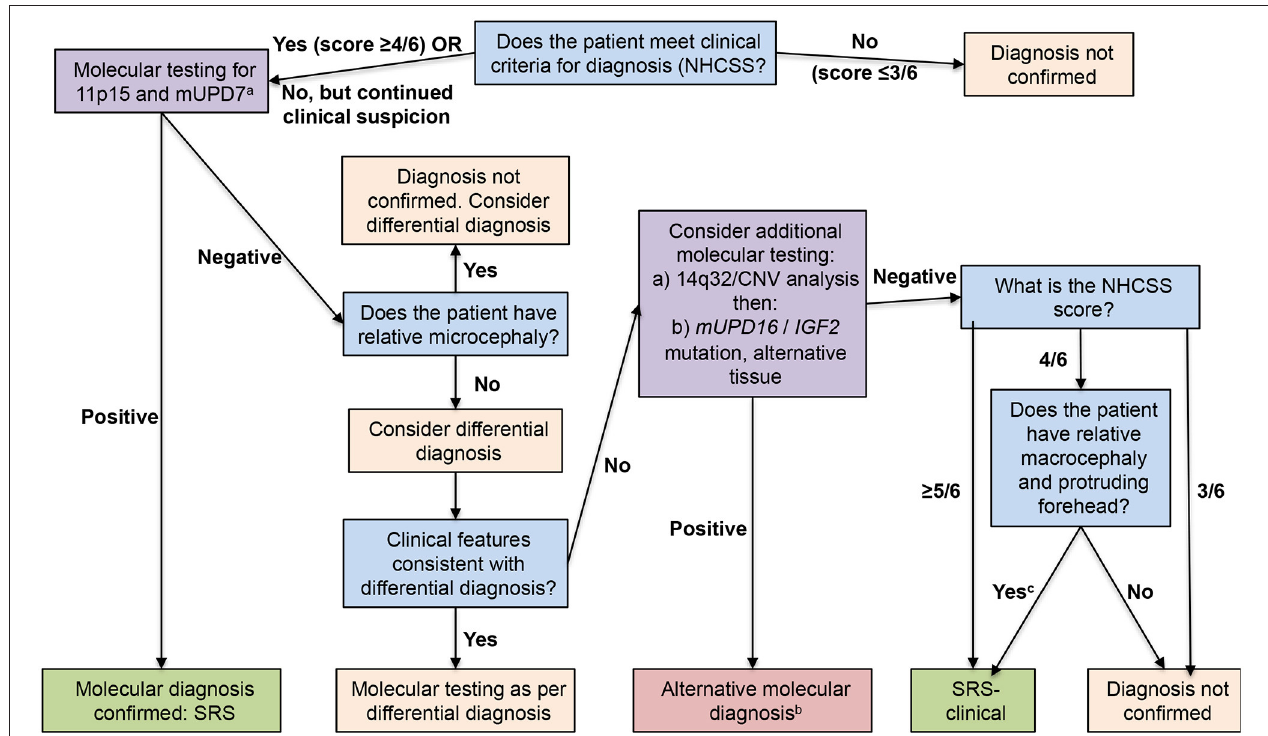
FIGURE 1 | Flow chart for investigation and diagnosis of patients with suspected Silver-Russell syndrome. Blue boxes show diagnostic questions, mauve boxes recommended molecular testing, pink boxes diagnosis not confirmed, and green boxes diagnosis confirmed. Reproduced from: Wakeling et al. (52). a Arrange copy number variant analysis before other investigations if patient has notable unexplained global developmental delay and/or intellectual disability and/or relative microcephaly; b Insufficient evidence at present to determine relationship to Silver-Russell syndrome, with the exception of tissue mosaicism for 11p15 loss of methylation; c Previously known as idiopathic Silver-Russell